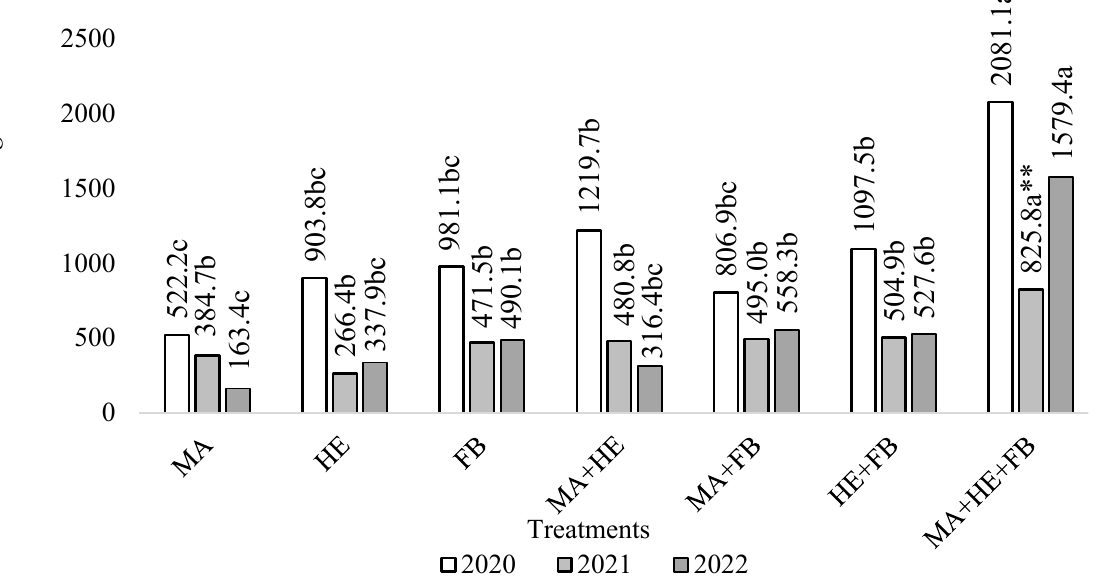
Figure 7. Impact of multi-cropping level on total dried biomass of cultivations, 2020–2022. MA, single maize crop; HE, single hemp crop; FB, single faba bean crop; MA + HE, binary maize and hemp crop; MA + FB, binary maize and faba bean crop; HE + FB, binary hemp and faba bean crop; MA + HE + FB, ternary crop of maize, hemp and faba bean. Different letters (a, b, c) within columns of separate vegetative season show significant difference between treatments at p ≤ 0.05; ** p at ≤ 0.01. The faba bean single crop had, on average, 647.6 g m − 2 dry biomass per year,